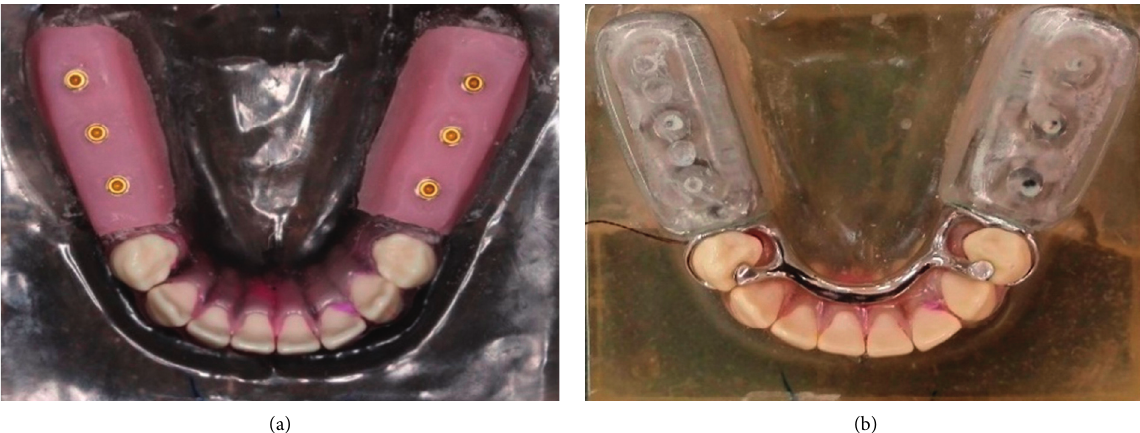
Figure 1: (a) The mandibular model with preformed acrylic resin teeth, the polyvinyl siloxane-simulated PDL, and gingival tissue on edentulous ridges. (b) RPD metal framework for distal extension RPD with bilateral acrylic resin bases on the edentulous areas.